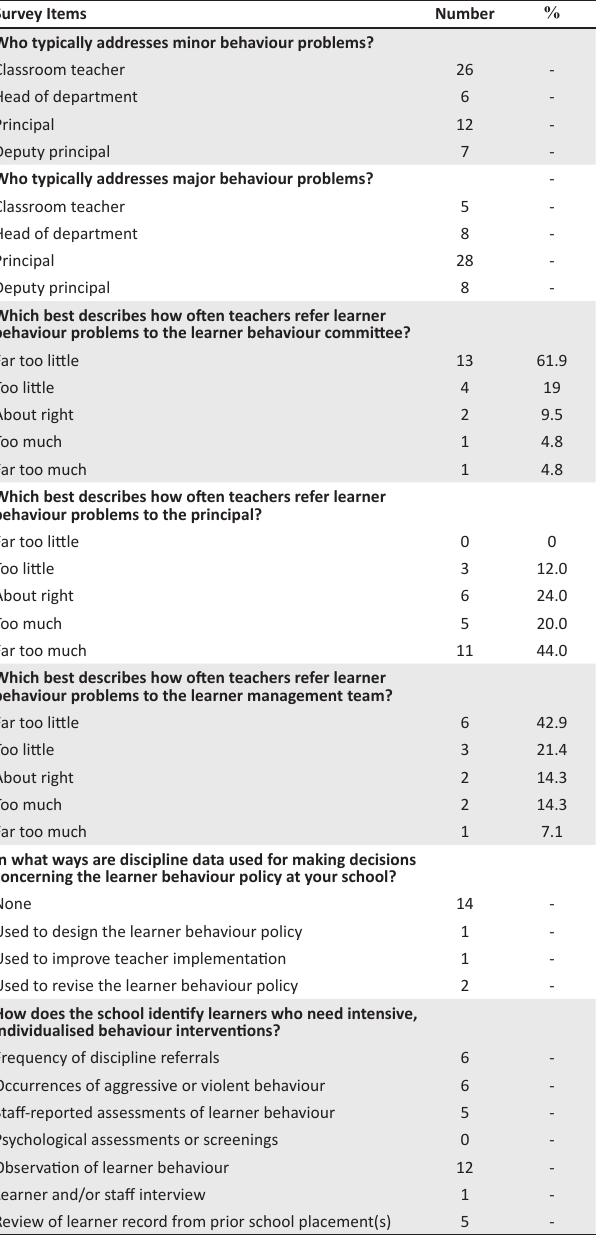
TABLE 3: Continuous progress monitoring. Survey Items